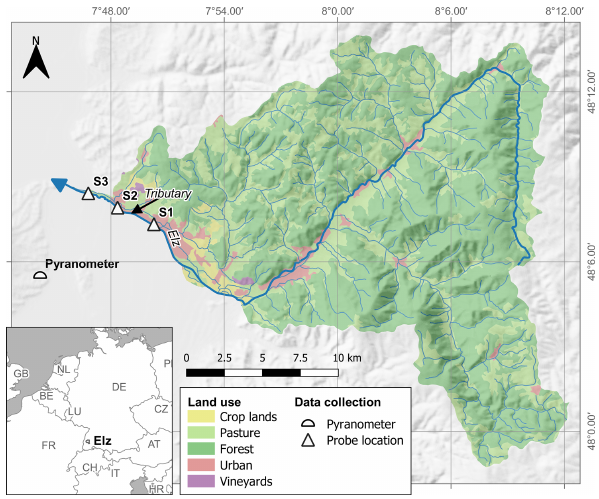
Figure 1. Location of monitoring points along the stream reach and land use in the contributing